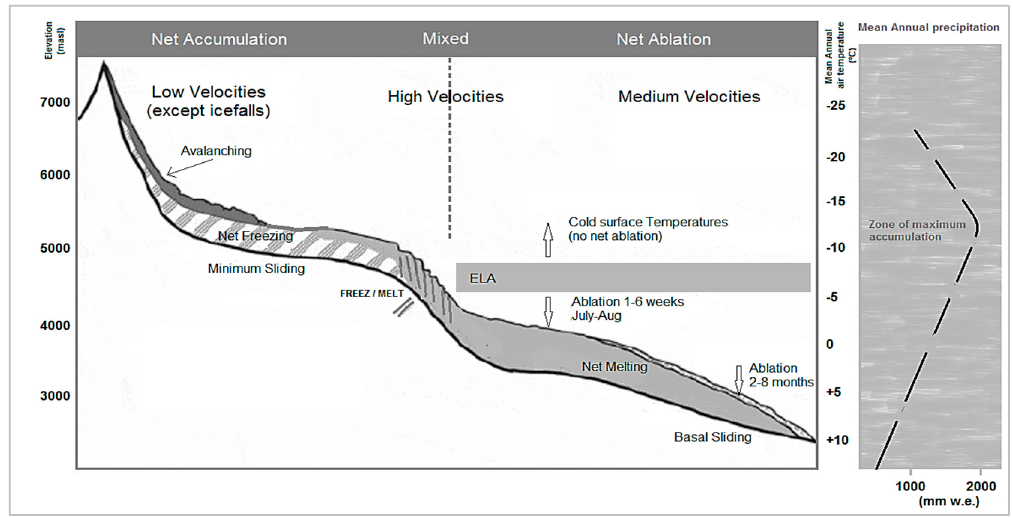
Figure A1. Vertical and horizontal meteorological and cryspheric regimes in UIB (modified from Hewitt 2007).